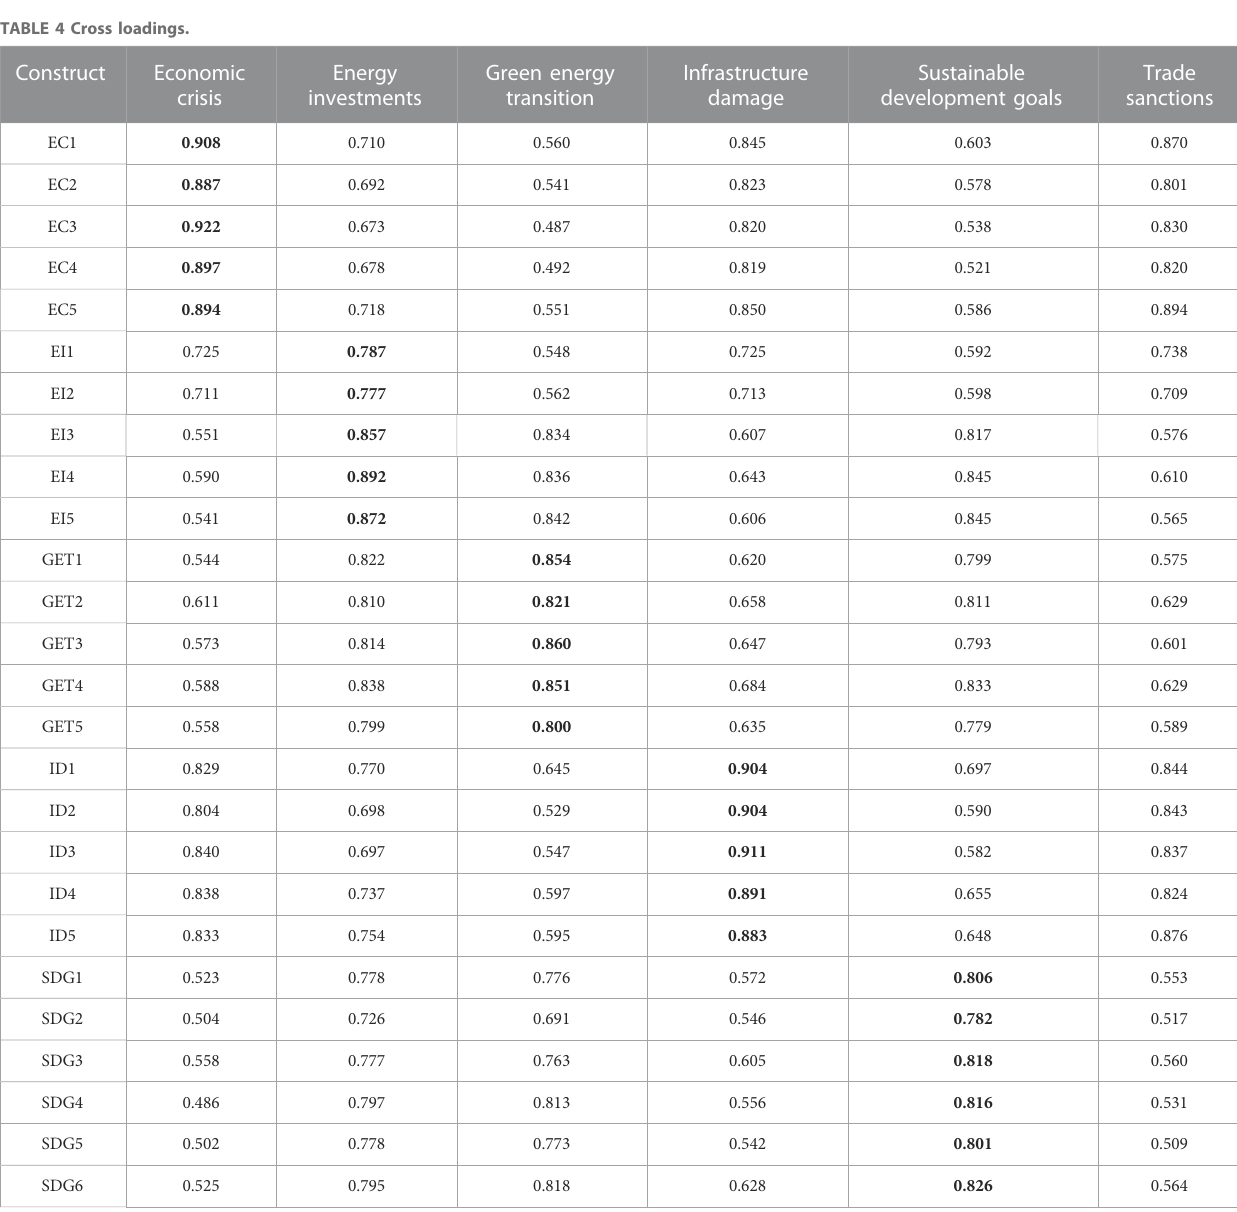
FIGURE 3 Convergent validity.